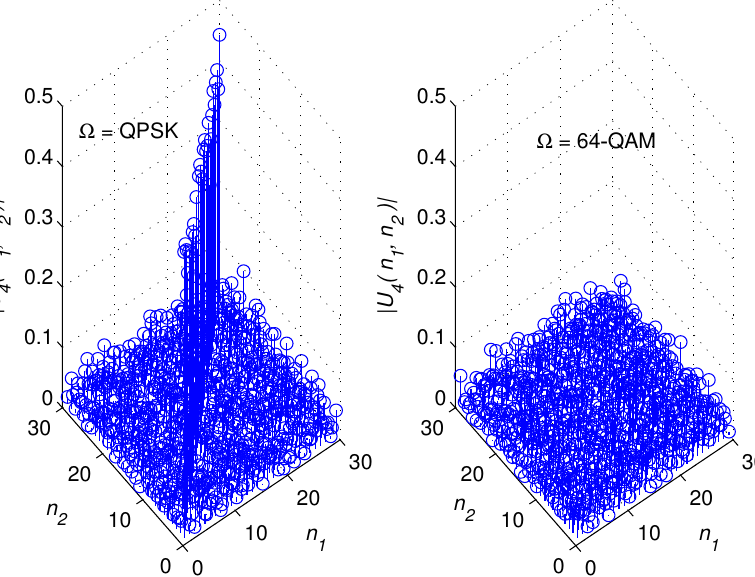
Figure 5. The magnitude of the fourth correlation function at the modulation forms of QPSK and